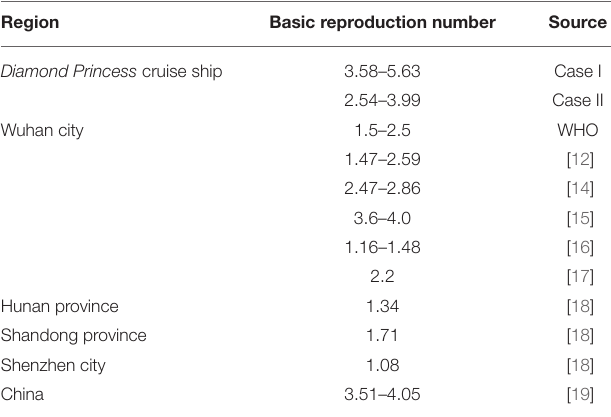
TABLE 4 | Comparison of the basic reproduction number in different